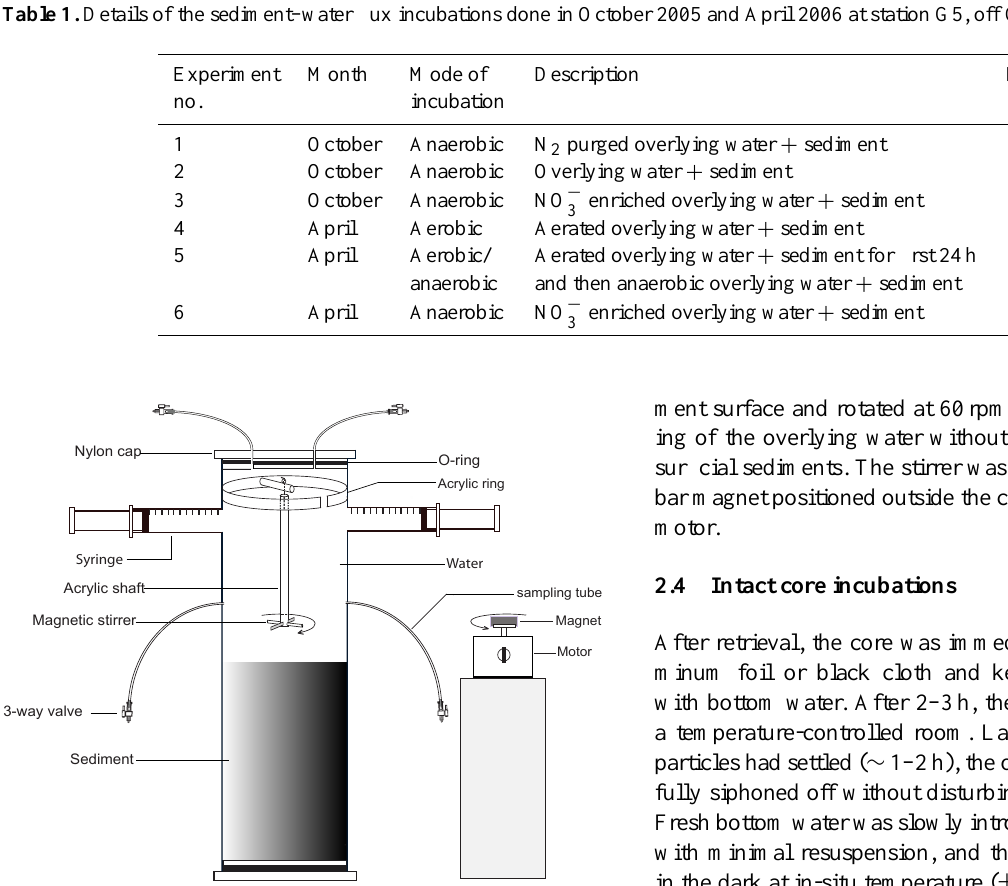
Table 1. Details of the sediment–water flux incubations done in October 2005 and April 2006 at station G5, off Goa.